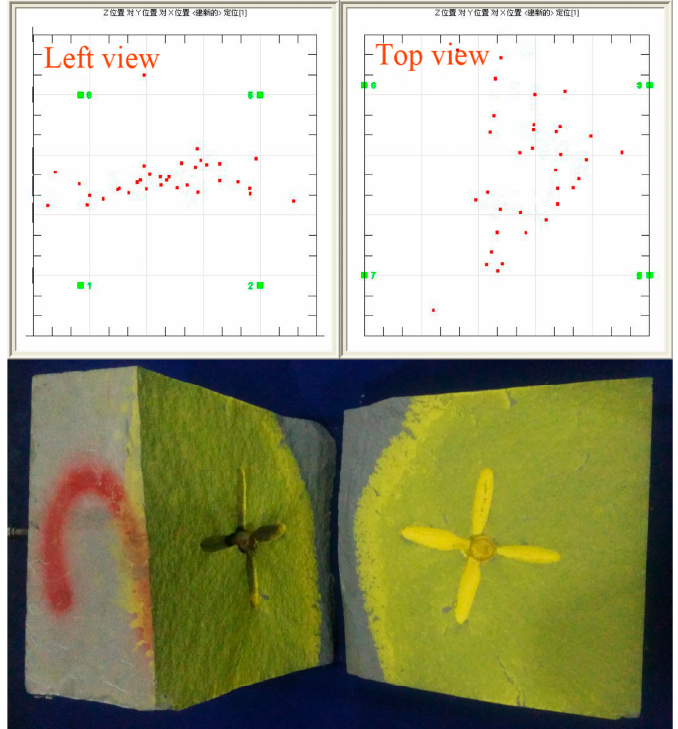
Figure 12. Comparison of AE events (left view and top view) in terms of spatial orientation, and fracture positions in the specimen.